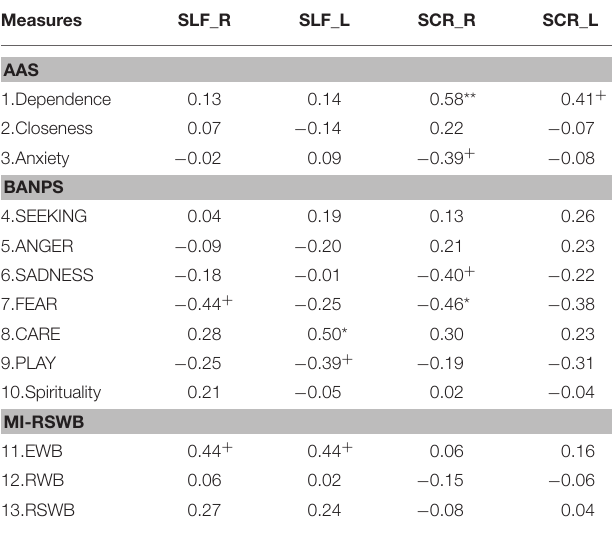
TABLE 5 | Correlations of behavioral measures with FA in the selected ROIs for PUD ( n = 19).